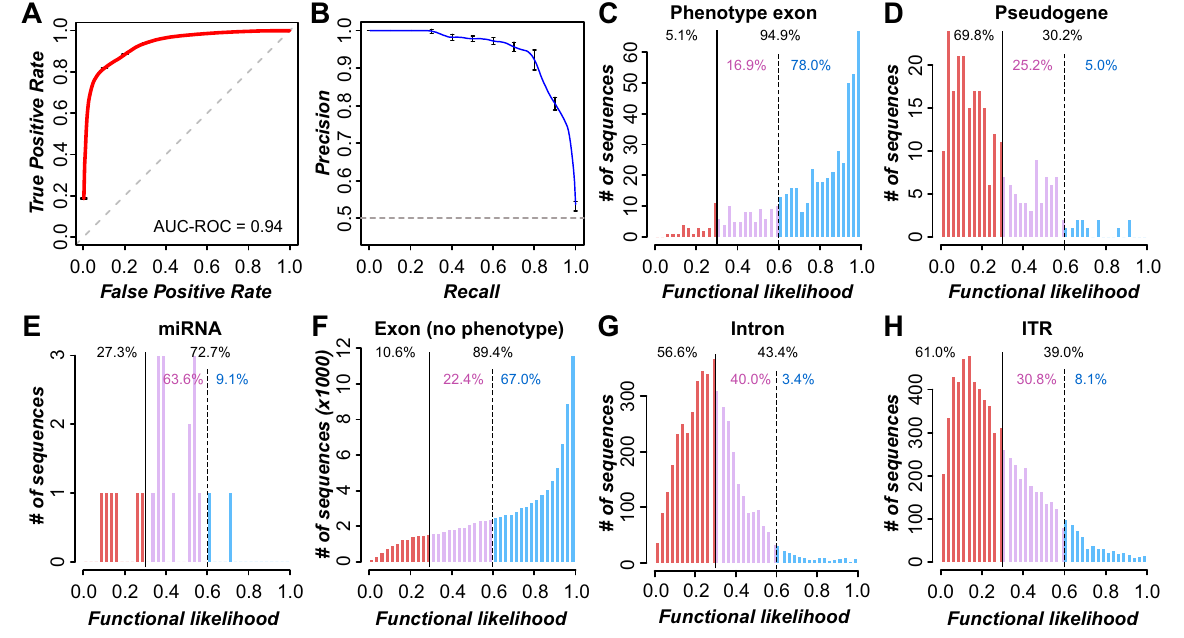
Figure 5. Machine learning-based functional predictions in rice. ( A ) Receiver operating characteristic (ROC) curve for predictions of phenotype exons and transcribed pseudogenes. AUC-ROC: area under curve-ROC. ( B ) Precision-recall curve for the predictions from ( A ). Gray dashed lines (A,B) : random expectation. (C–H ) Histograms of functional likelihood scores for phenotype exons ( C ), pseudogenes ( D ), transcribed miRNAs ( E ), transcribed exons without phenotype evidence ( F ), transcribed introns that are not alternatively spliced ( G ), and ITRs ( H ). Dotted black line: threshold T 1 based on a 5% false positive rate. Solid black line: threshold T 2 based on a 5% false negative rate. Blue, purple, and red: phenotype exon-like, ambiguous, and transcribed pseudogene-like,